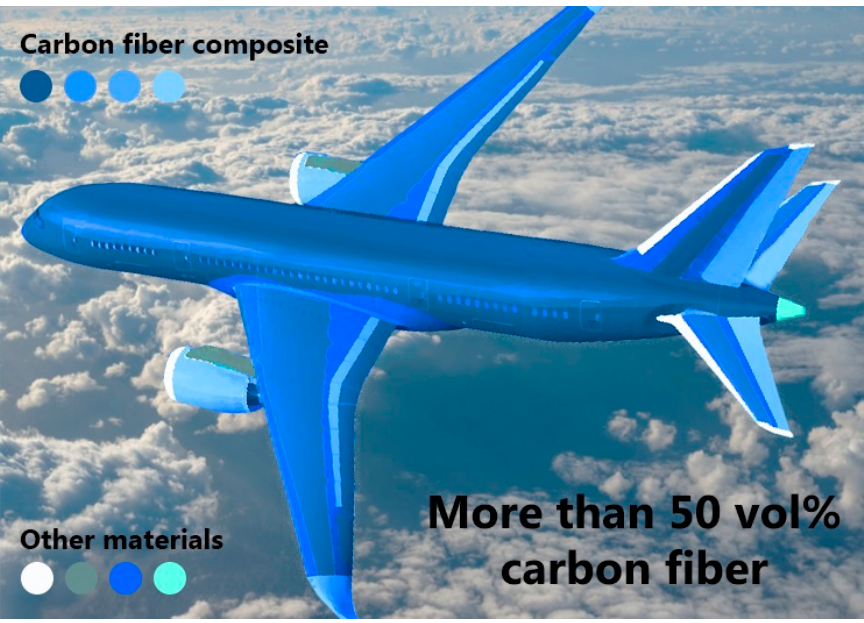
Figure 1. Materials analysis for a typical carbon-fiber-reinforced plastic (CFRP) aircraft.